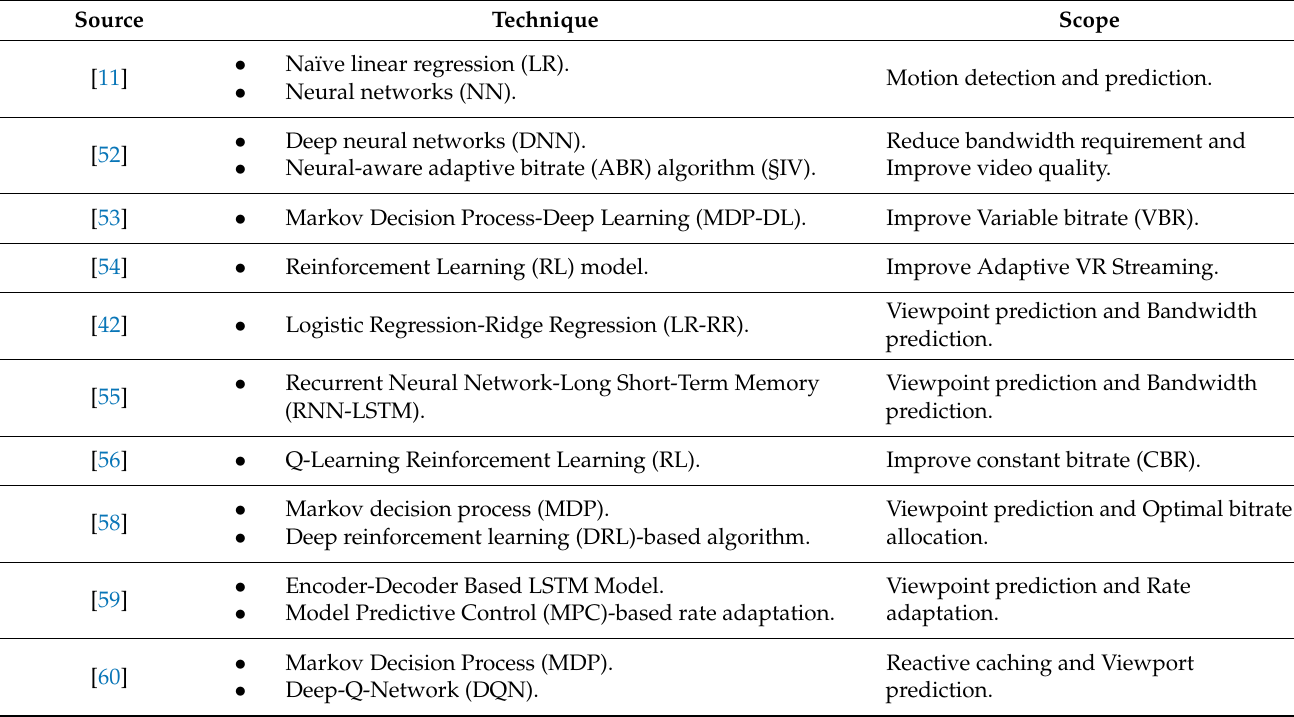
Table 5. Machine learning (ML)-based